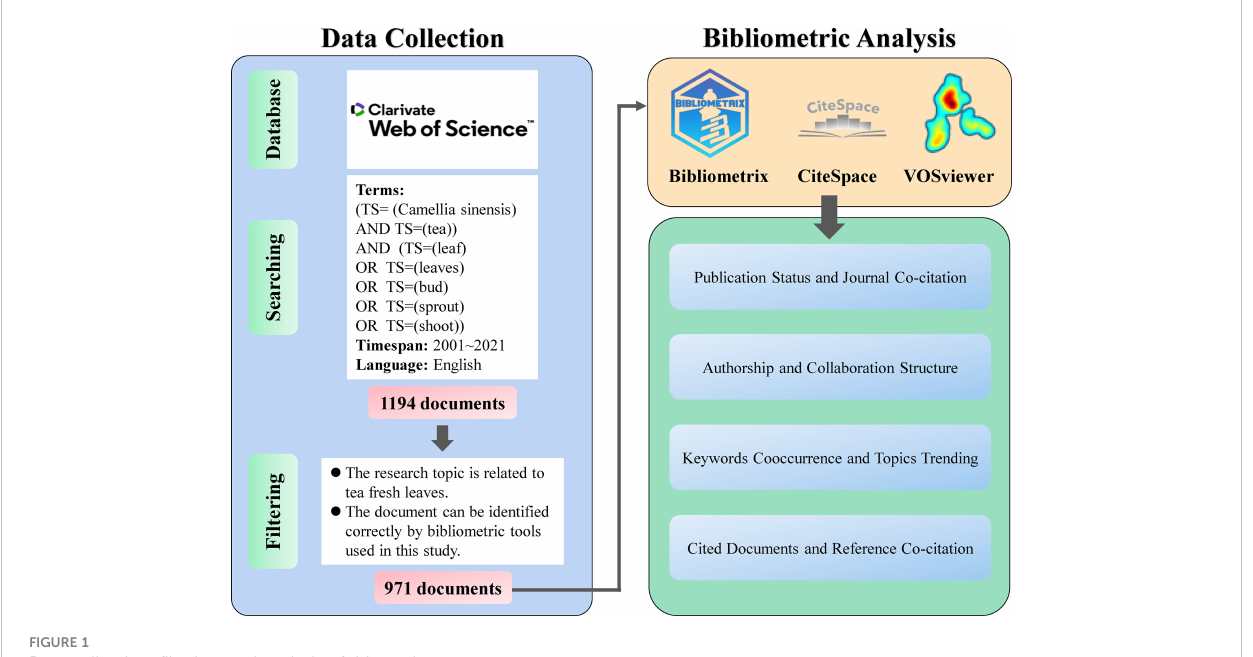
FIGURE 1 Data collection, fi ltering, and analysis of this